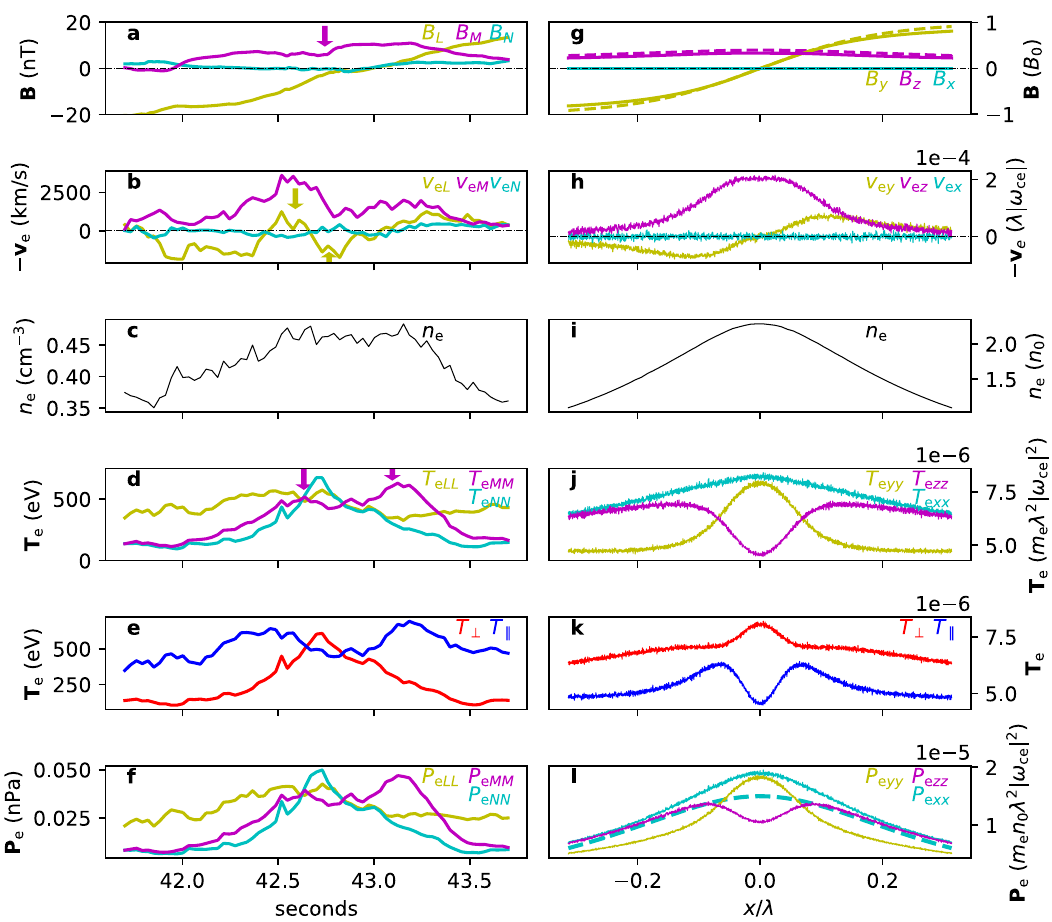
Fig. 7 | Comparison of MMS data to the PIC simulation. a – f Sequentially, the magnetic fi eld B , electron velocity v e (note that the sign is reversed), electron density n e , diagonal elements of the electron temperature tensor T e , the parallel andperpendicularelectrontemperatures T e ∥ and T e ⊥ ,anddiagonalelementsofthe electron pressure tensor P e detected by the Magnetospheric Multiscale spacecraft